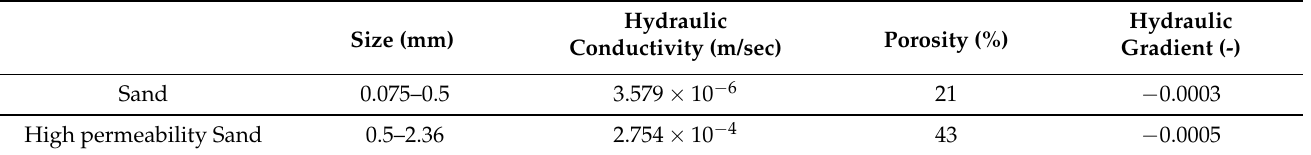
Figure 5. Schematic representation of the physical tank test ( a ), the 3 constructed layers and the sampling ports on tank ( b ). Table 2. The properties of the different sands used in the tank experiments.